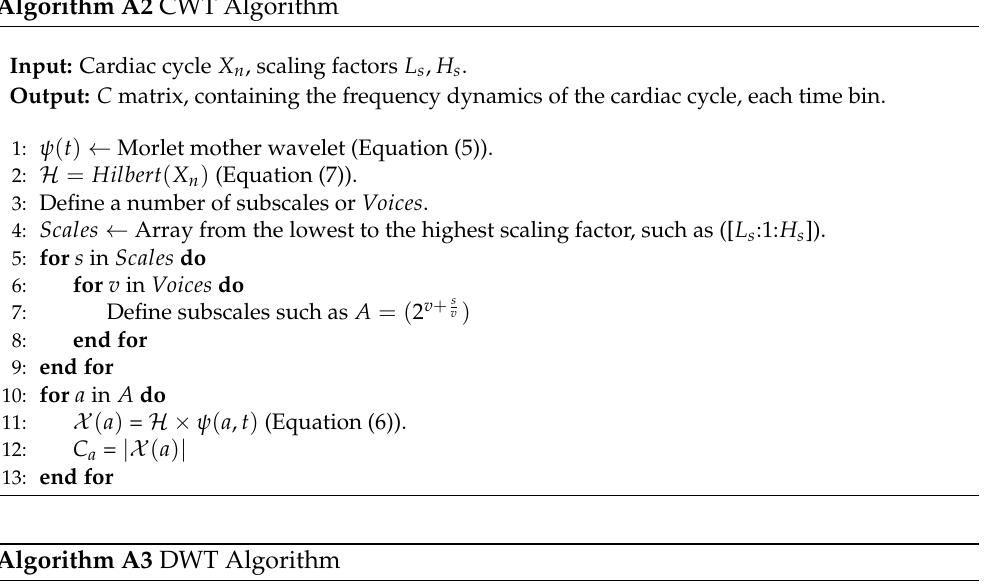
Algorithm A2 CWT Algorithm